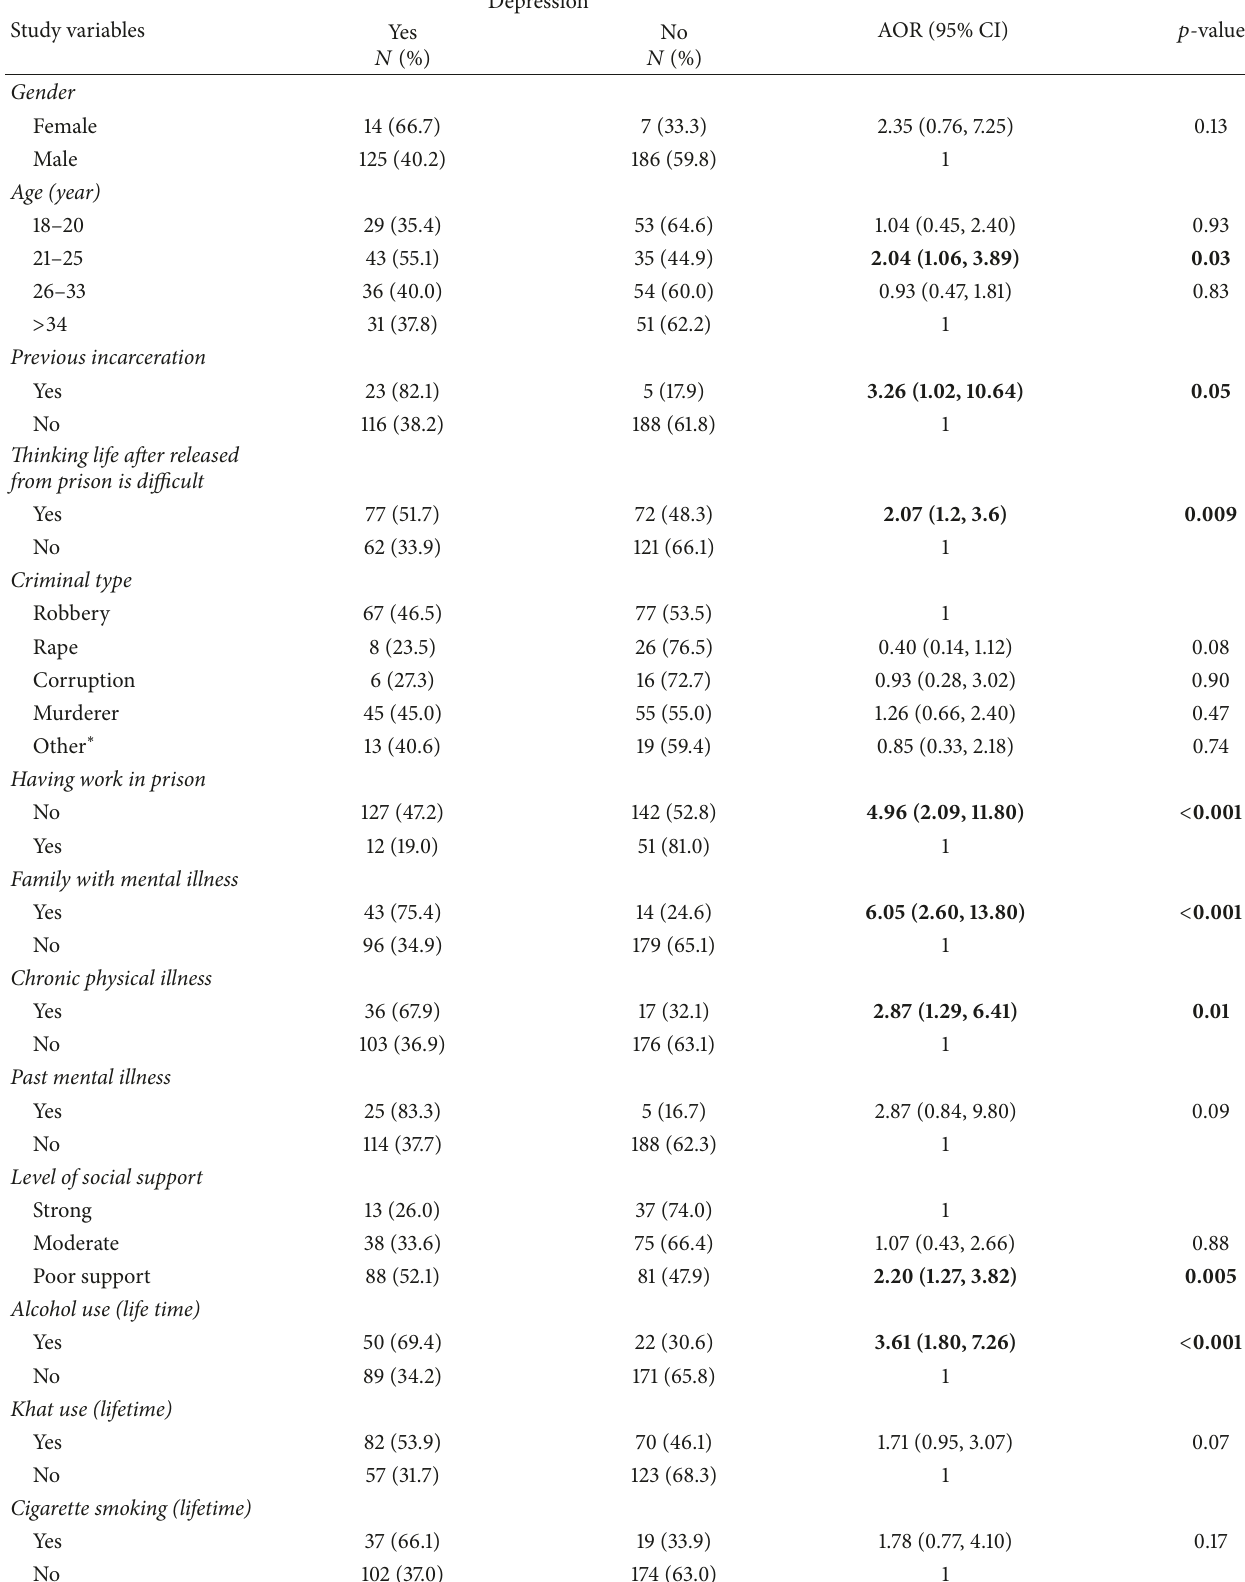
Table 4: Factors associated with depression by multivariable logistic regression among prisoners in Jimma town prison, South West Ethiopia, June 2017 ( 𝑁 = 332